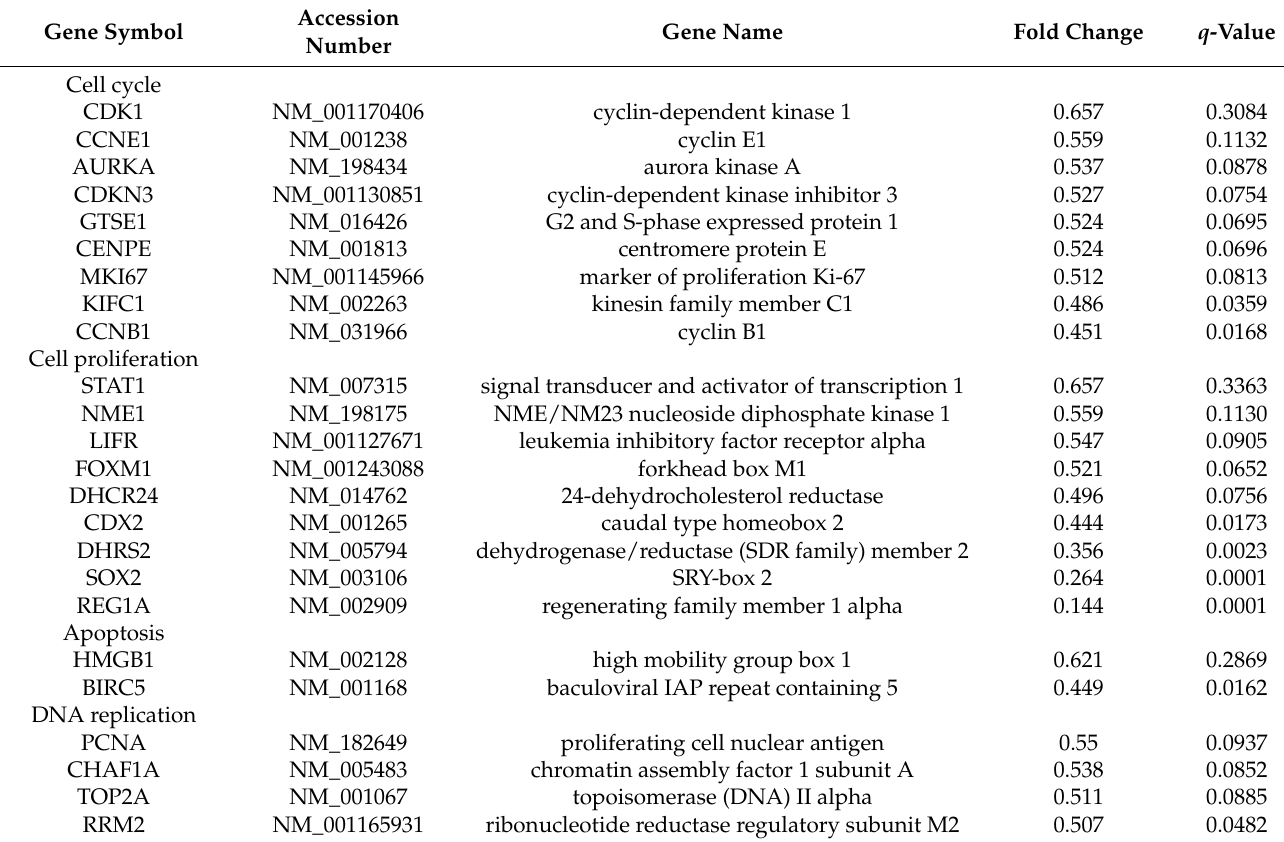
Table 2. Genes that are downregulated by DAA treatment in AGS